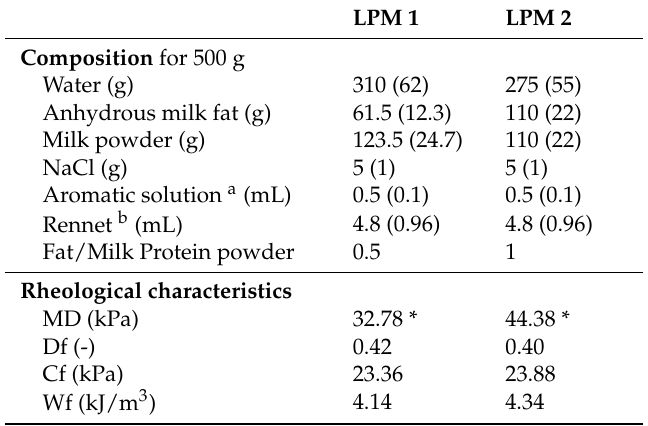
Table 1. Composition and characteristics of the lipoprotein matrix (LPM) samples (% of total